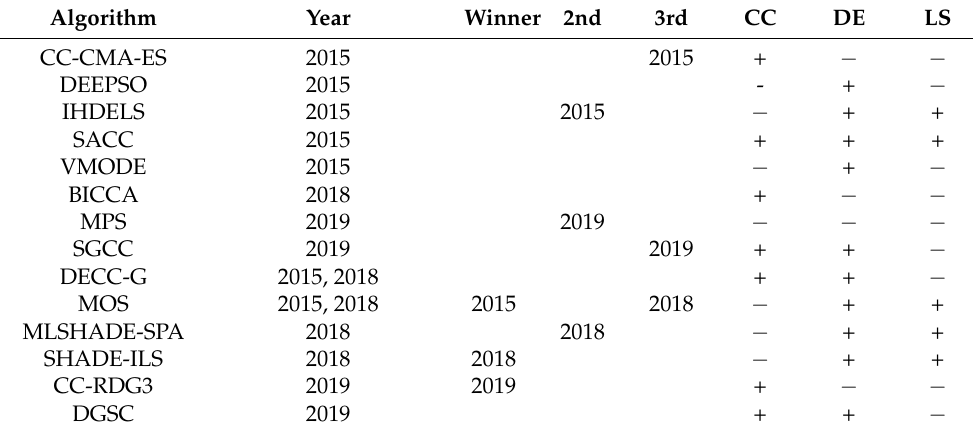
Table 2. LSGO state-of-the-art